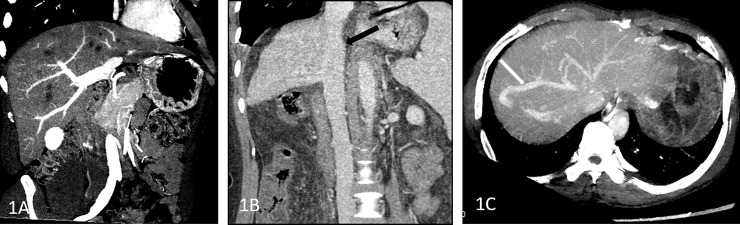
Vascular reconstruction of PV, HV, and IVC.A maximum intensity projection (MIP) image of the PV, showing the PV trunk and its branches clearly; Fig 1B curve planar reformation (CPR) image of the IVC, showing the IVC patency (black arrow); Fig 1C maximum intensity projection(MIP) image of the HV, showing the left HV, HV and right HV occlusion, subhepatic vein open, through the auxiliary hepatic vein (white arrow) into IVC.